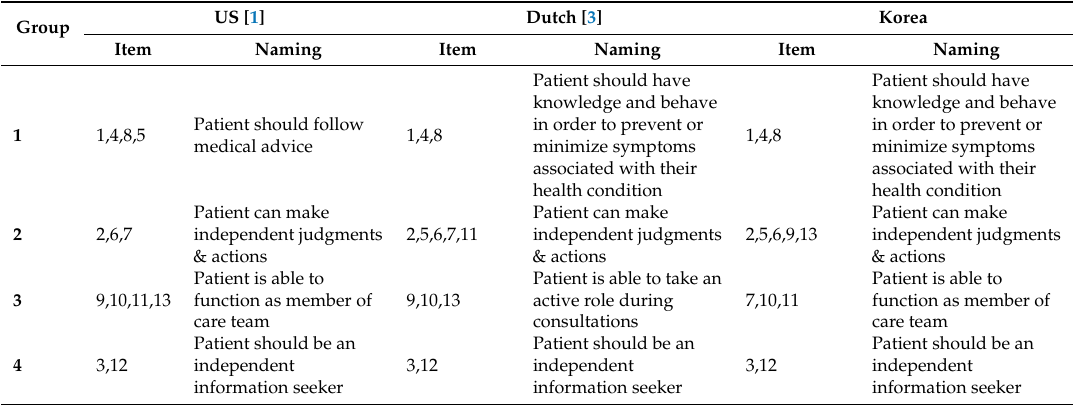
Table A1. Comparison to groups classification the CS-PAM by the US, Dutch, and